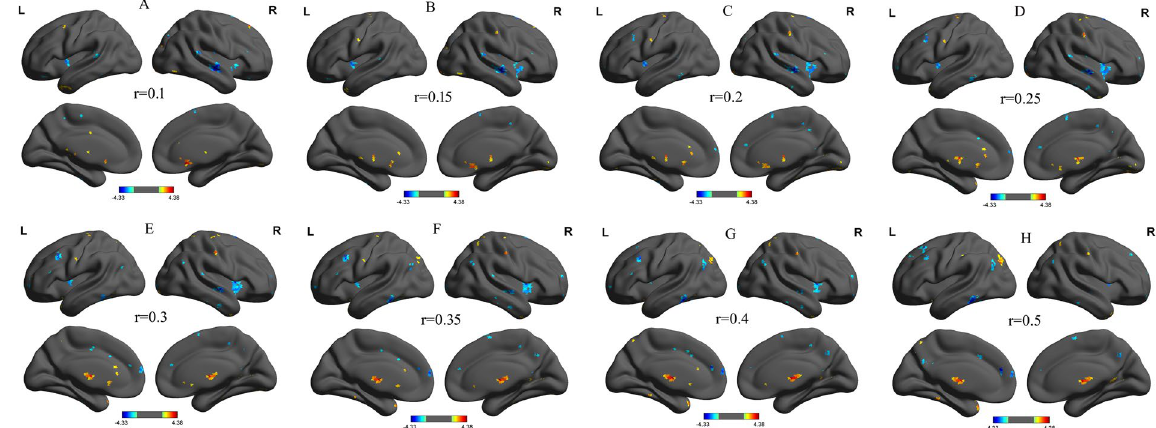
Figure 2. Binarized degree centrality mapswith several threshlod between PIs and GSs. Note: Betweent-group differences of binary network with different threshold at r = 0.10 ( A ), 0.15 ( B ), 0.20 ( C ), 0.25 ( D ), 0.30 ( E ), 0.35 ( F ), 0.40 ( G ) and 0.50 ( H ). Abbreviations:R, right; L, left; PIs, Patients with primary insomnia; GSs, Good